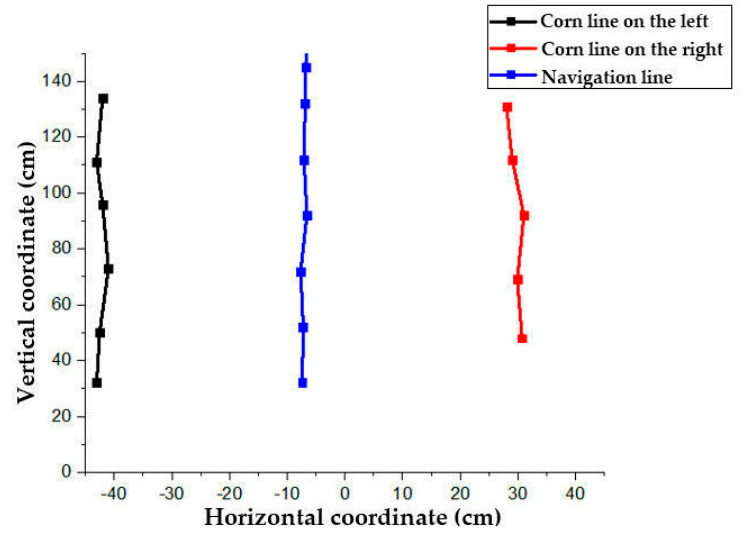
Figure 12. World coordinate system diagram.